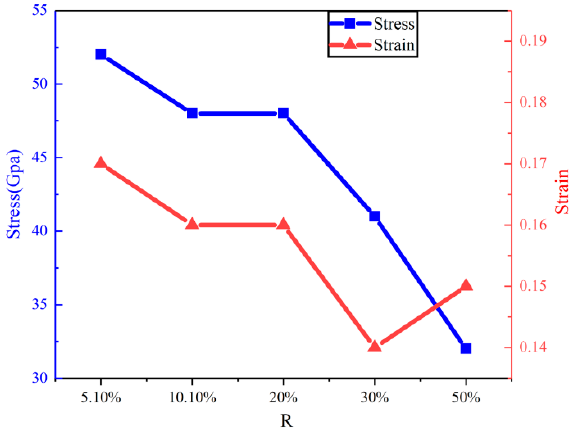
Figure 8. Ultimate stress and ultimate strain values of PGO under different oxygen content ( θ = 21.8°).